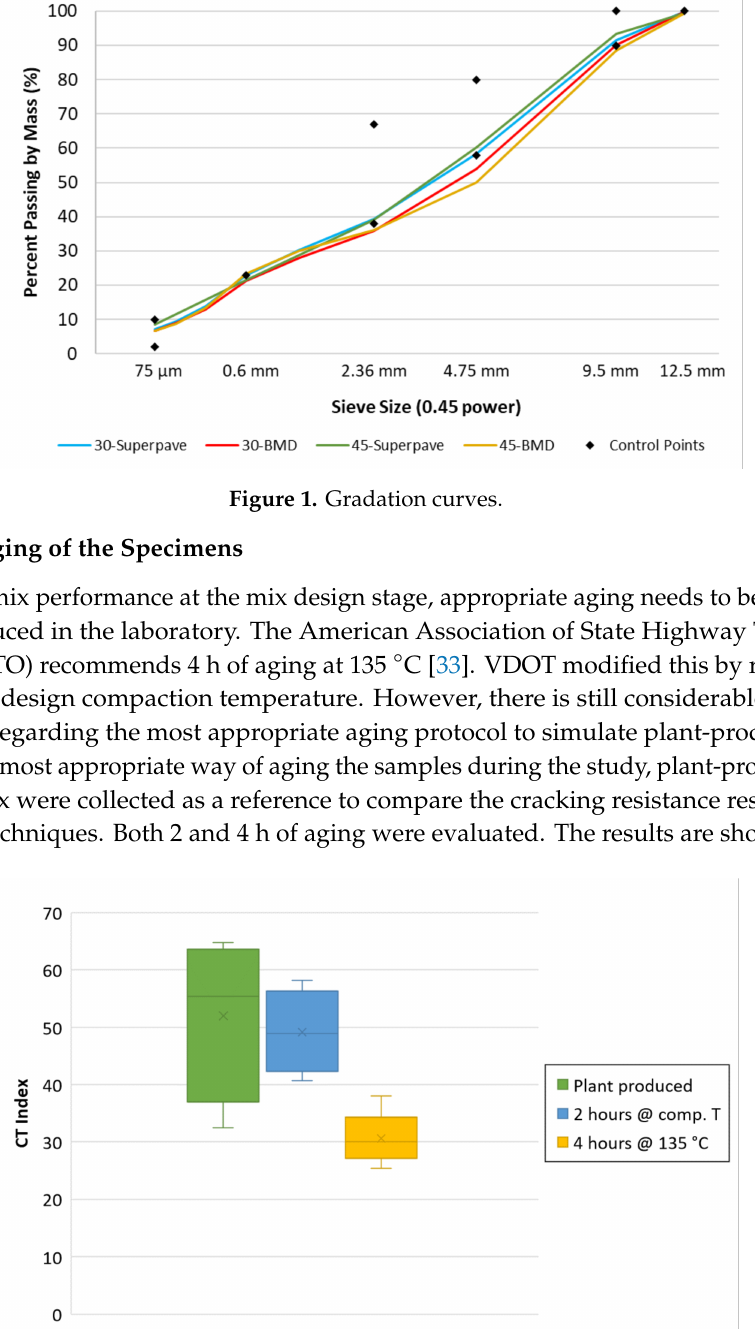
Figure 2. Aging impact on recorded cracking resistance of the control mix (30-Superpave). The middle line of the box represents the median, the x in the box represents the mean (four specimens per aging